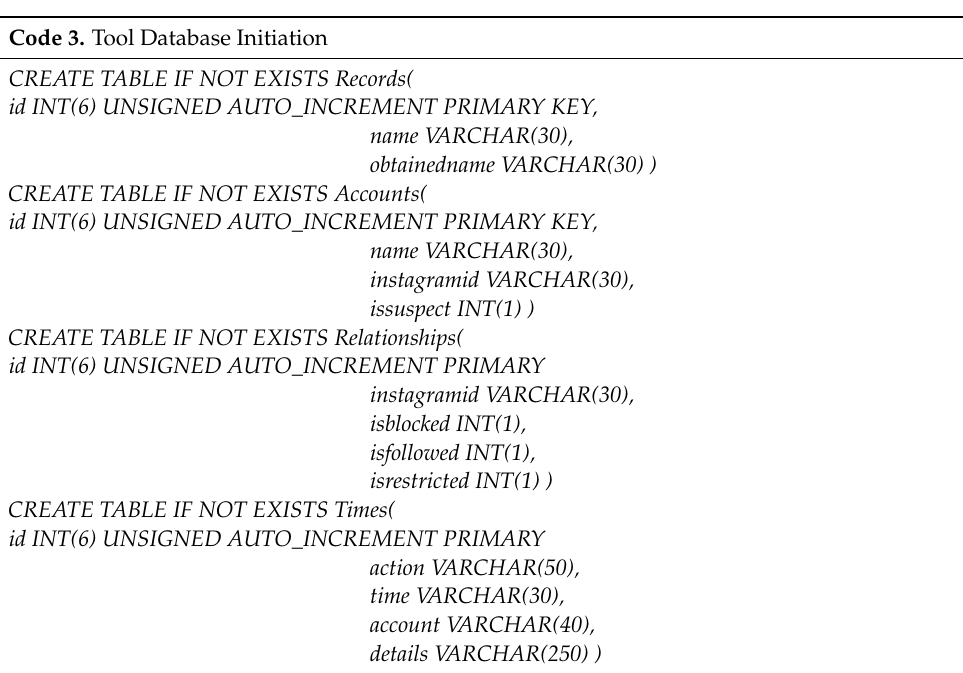
Figure 7. Tool Modules.